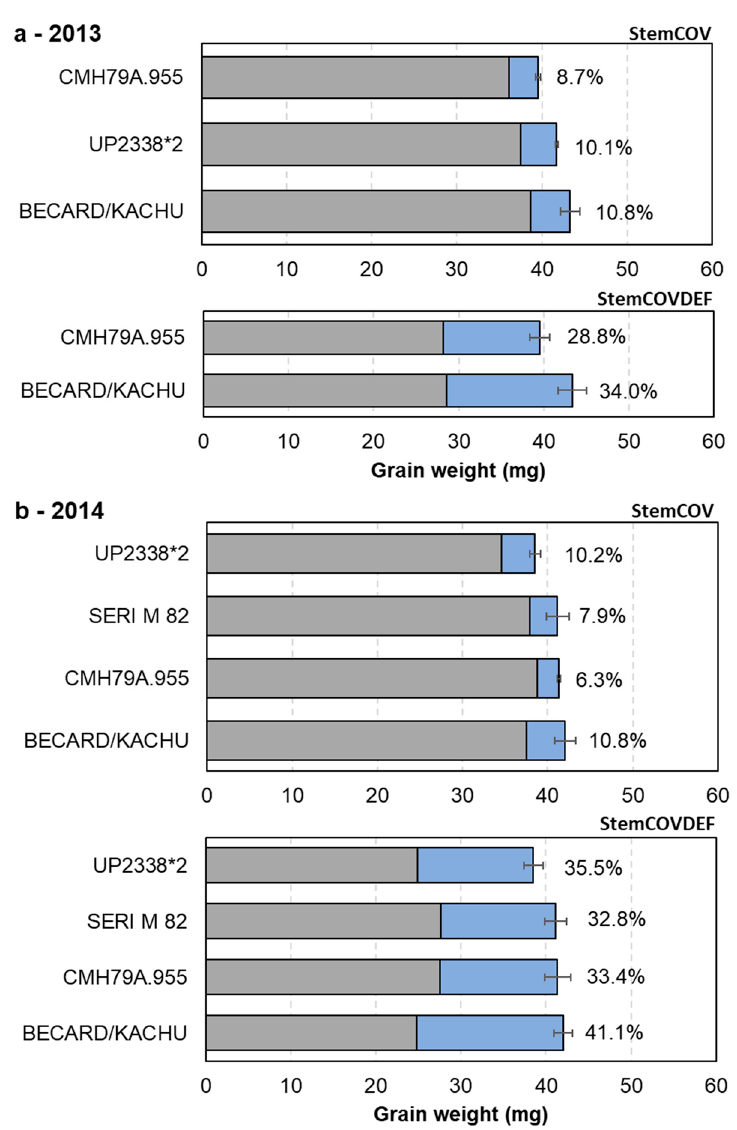
Figure 5. Grain weight in manipulated shoots (grey bars) and difference between control and manipulated shoots (blue bars) in ( a ) 2013 for a selection of three (StemCOV, p < 0.001 for cultivar and treatment) and two cultivars (StemCOVDEF, p < 0.001 for cultivar and p = 0.057 for treatment) and ( b ) 2014 for subset 2 (StemCOV and StemCOVDEF, p < 0.01 for cultivar and p < 0.001 for treatment). Error bars correspond to S.E. for the difference between grain weight in CTRL and manipulated shoots.